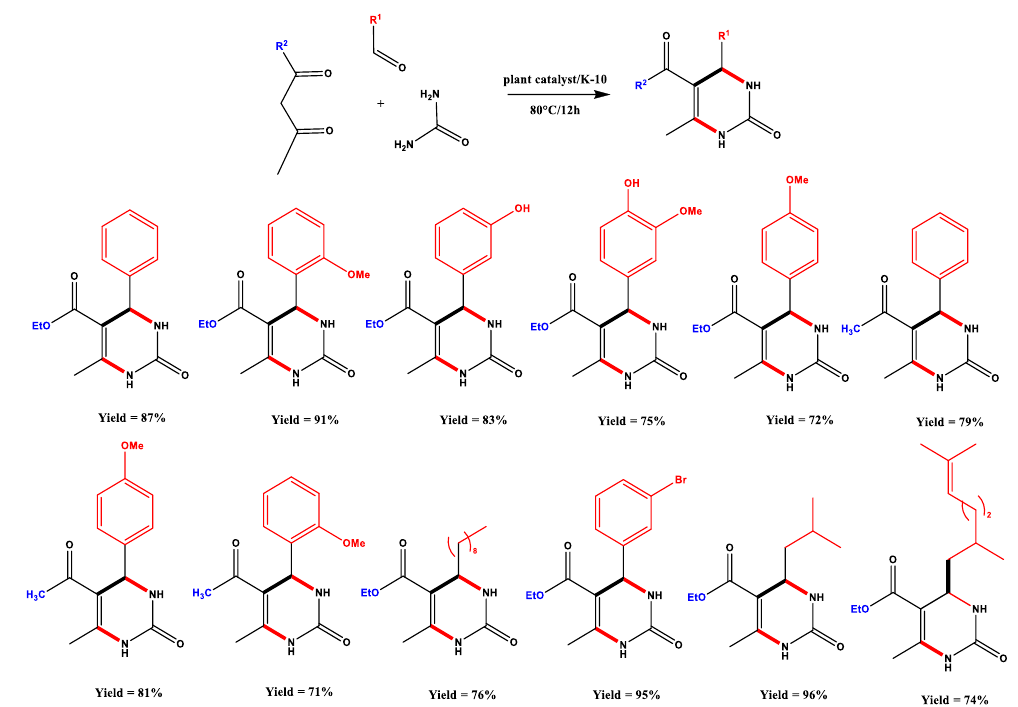
Scheme 7. Plant catalysed Biginelli reaction scope. Adapted from Reference